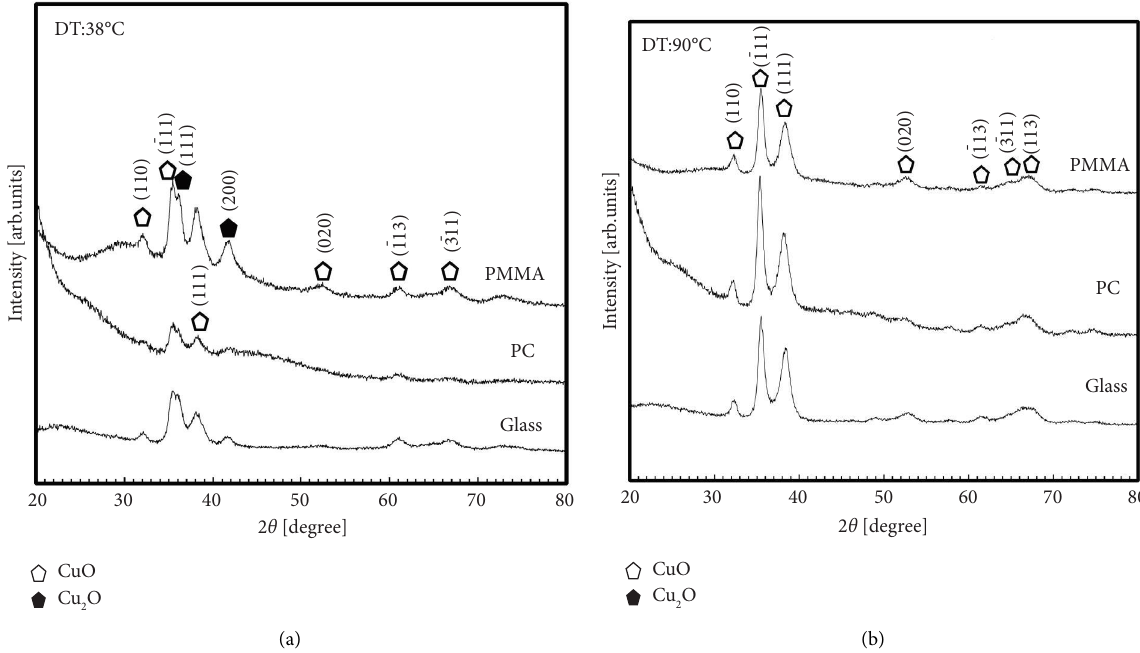
Figure 1: XRD characterization of samples (a, b) that formed at 10W on PMMA, PC, and glass